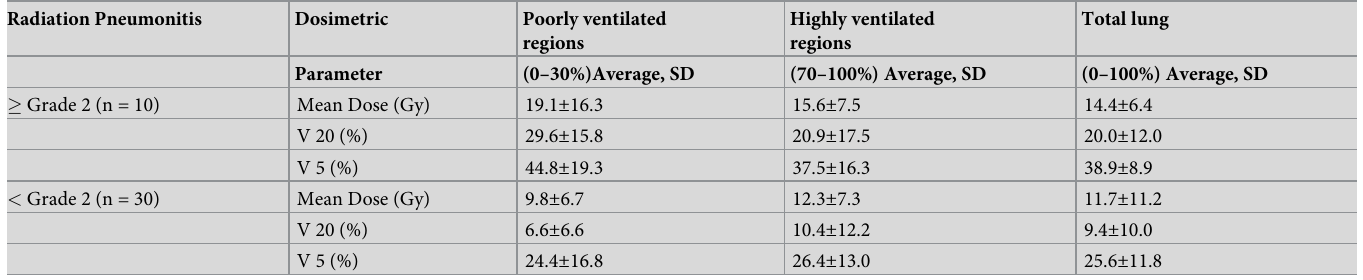
Table 2. Summary of the dosimetric parameters calculated for highly ventilated regions, poorly ventilated regions, and total lung for two patient sub-groups: One with radiation pneumonitis of (cid:21) Grade 2 and the other with radiation pneumonitis of Grade